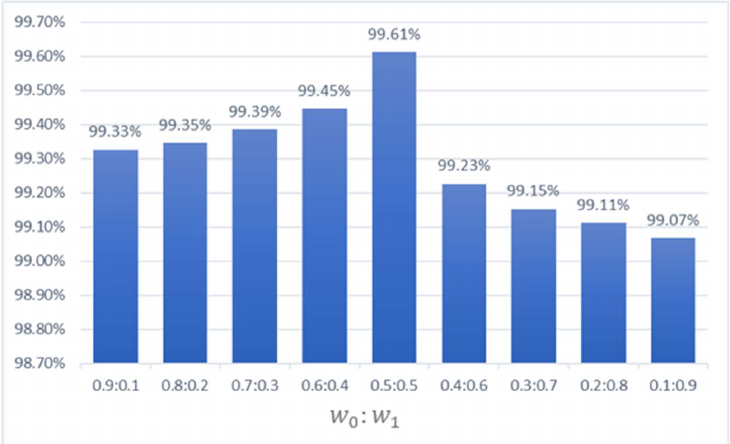
Figure 11. The performance of different fusion weights. 𝑤 (cid:2868) and 𝑤 (cid:2869) denote as the fusion weight of level 0 and level 1 models. level 0 and level 1